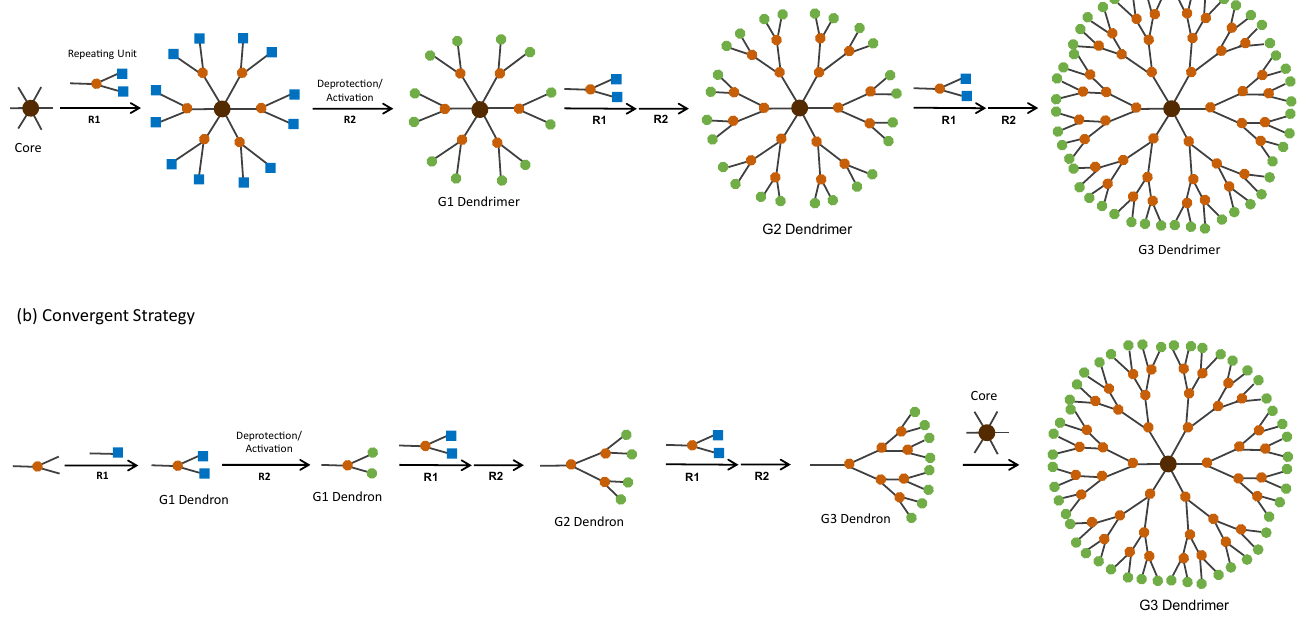
Figure 3. Classical strategies for the synthesis of dendrimers. Both strategies include growth reactions (R1) and deprotection/activation of the branching points (R2) to create a new generation of dendrimer/dendron. Squares represent protected/inactive functional groups and circles represent free/active functional groups. Adapted from Leiro et al. [14] © John Wiley & Sons, Inc. In the biomedical field, the most researched dendrimers are poly(amido amine) (PA- MAM), poly(propylene imine) (PPI), phosphorus-based dendrimers, poly(L-lysine)-based (PLL), carbosilane, poly(ether)-copoly(ester)(PEPE), poly(ether imine) (PETIM), polypheny- lene dendrimers, and gallic acid-triethylene glycol (GATG) dendrimers (Figure 4) [14]. PAMAM and PPI dendrimers were the first dendritic structures to be described [69,74] and later were made commercially available [16]. Consequently, they are the most widely used dendrimers. They both have polyamine groups on their surface, yet their synthesis and branching units are distinct. Comparing the two dendritic structures, PPI dendrimers are slightly smaller and have a more densely packed surface than PAMAM dendrimers with the same generation because of their shorter branching